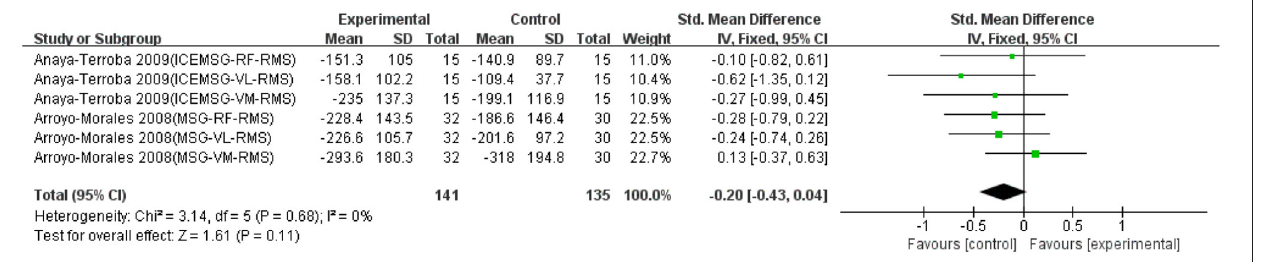
FIGURE 7 | The effectiveness of massage (MSG) on electromyography (EMG) signals of exercise-induced muscle